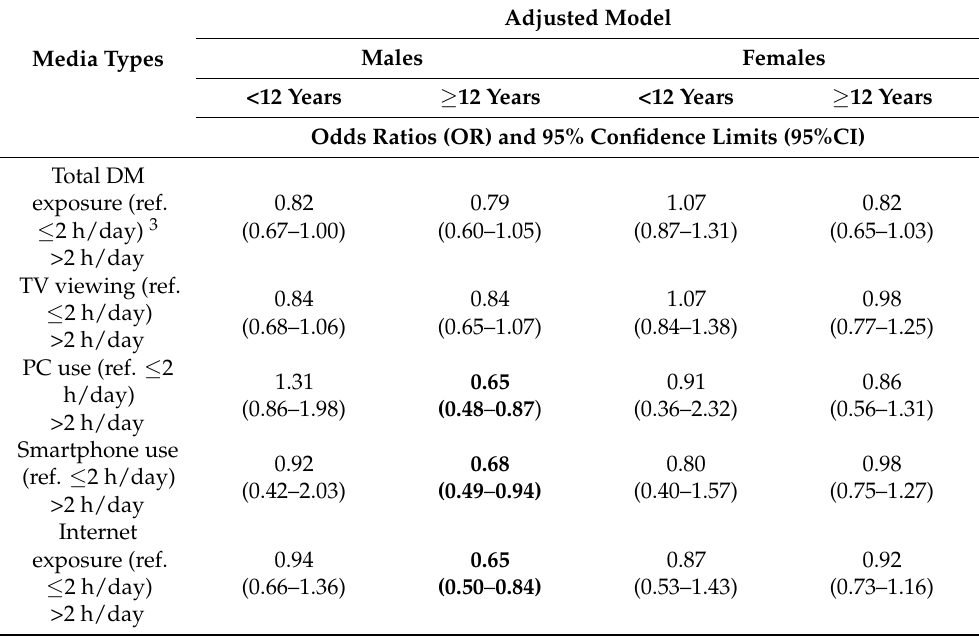
Table 5. Association of media use with bitter taste preference in European children and